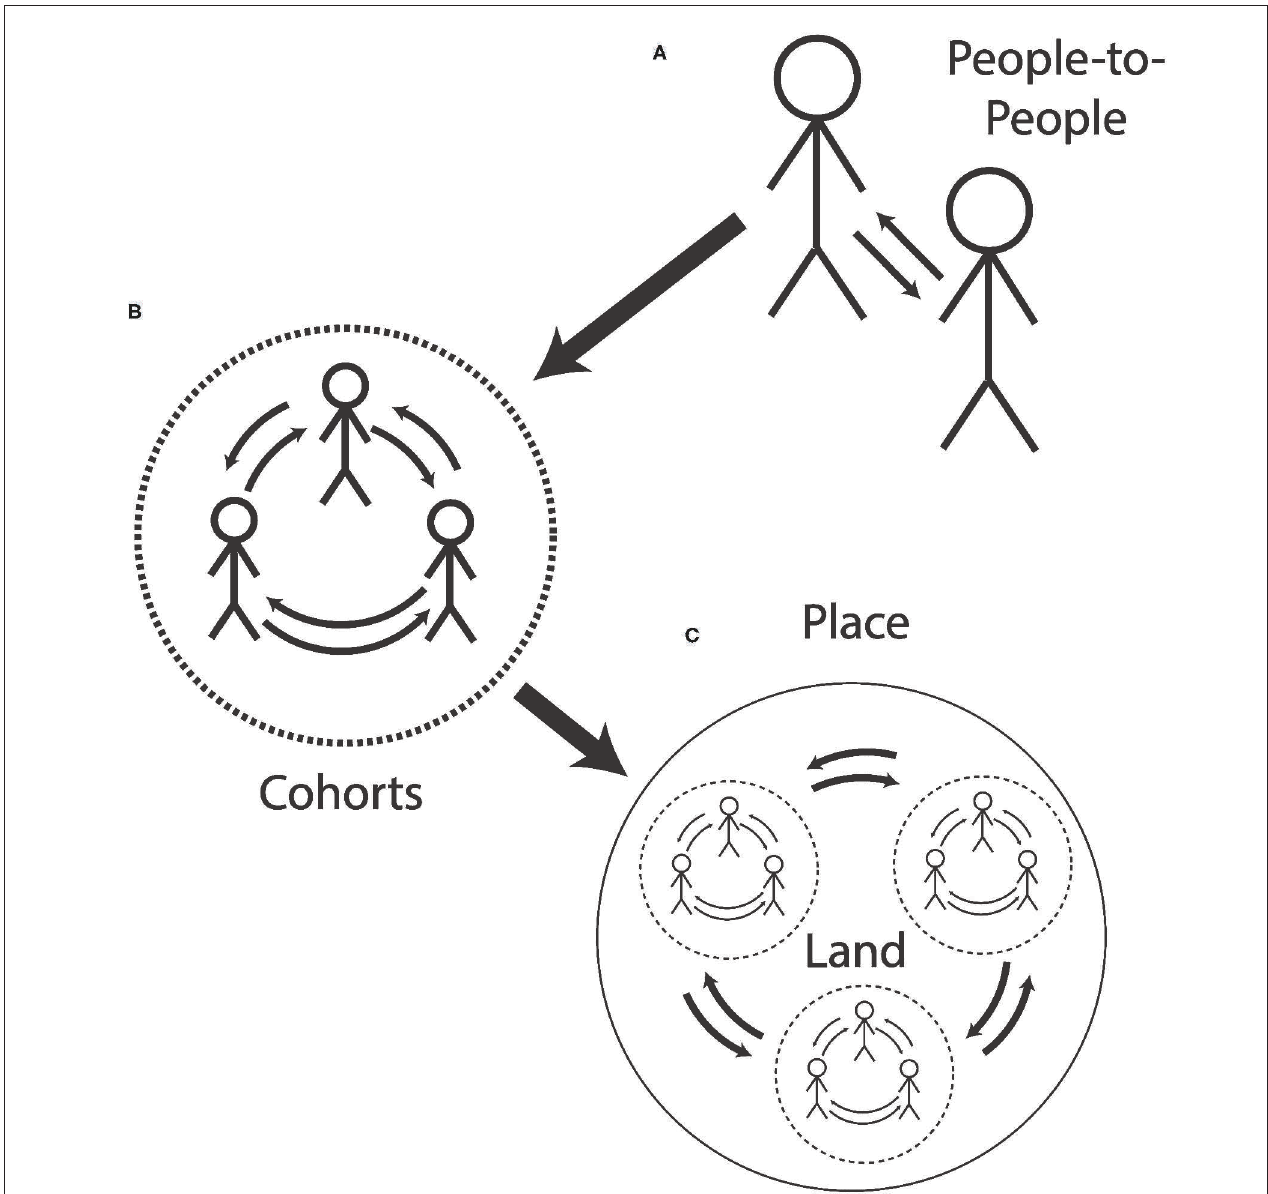
FIGURE 10 | Relationships between people and place. Through the “learning framework,” relationships form (A) between individuals, (B) within groups (cohorts), and (C) with